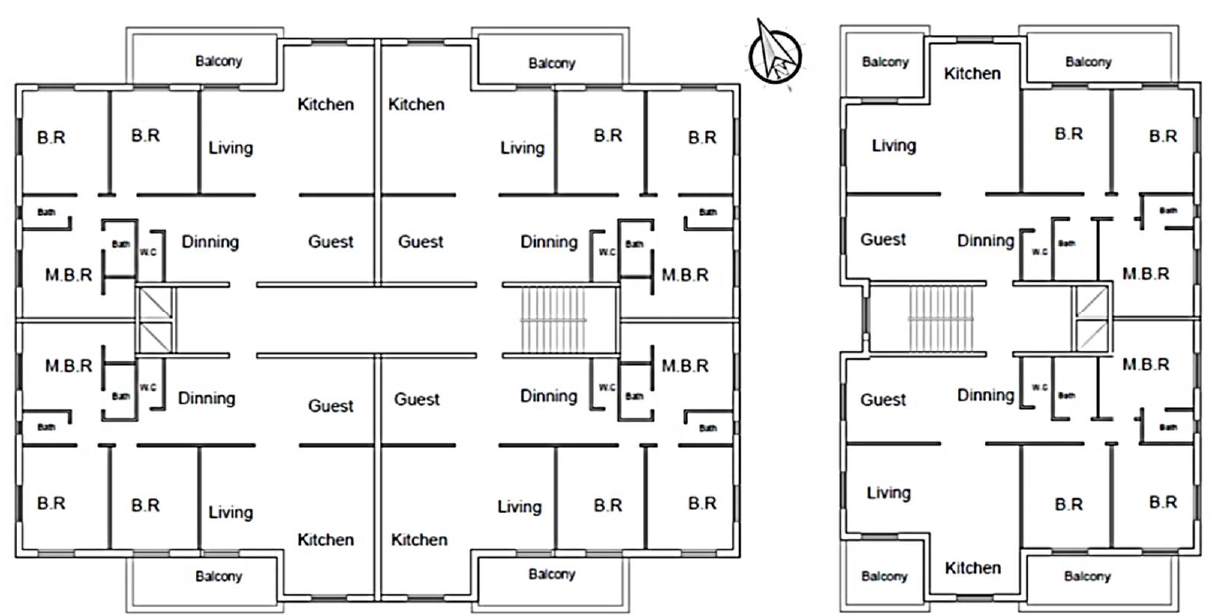
Figure 1. The representative building selected for the application of the retrofitting plan, on the left the building with four apartments at each floor, and, on the right, the building with two apartments on each floor.